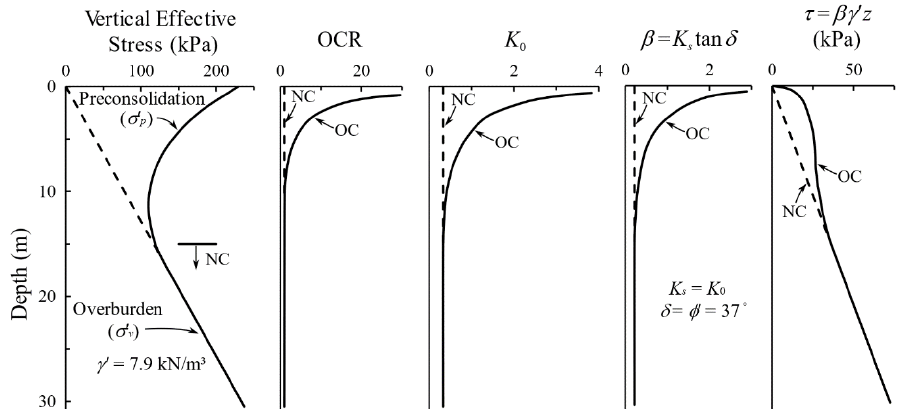
Figure 4. Example illustrating the principles of shaft resistance